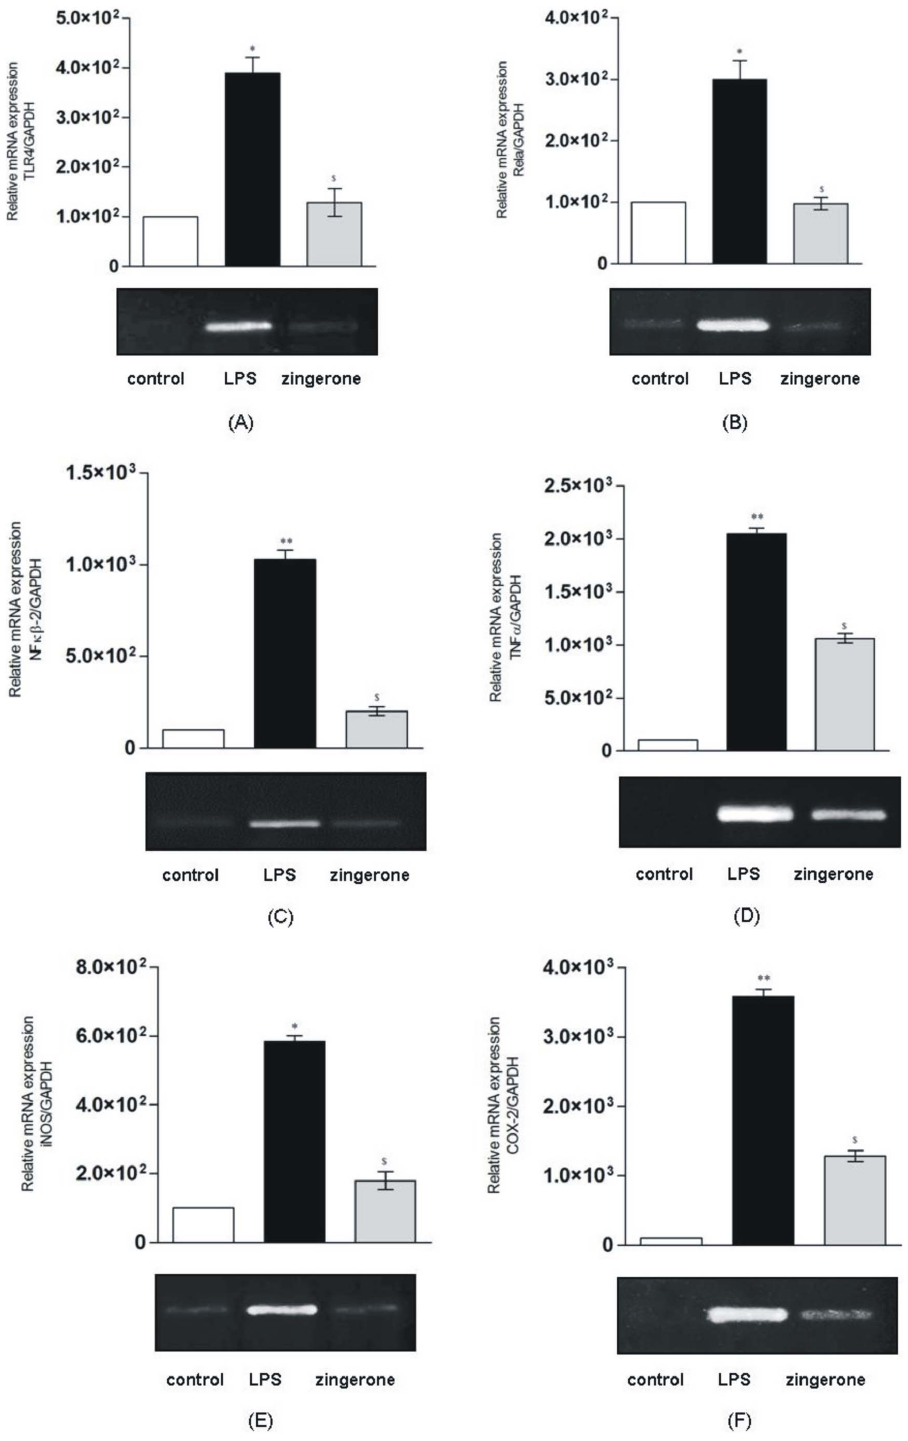
Figure 7. Effect of zingerone on the mRNA expression of inflammatory genes against endotoxin induced liver inflammation ( $ , * p , 0.01, $$ , ** p , 0.01 and ***, $$$ p , 0.001).